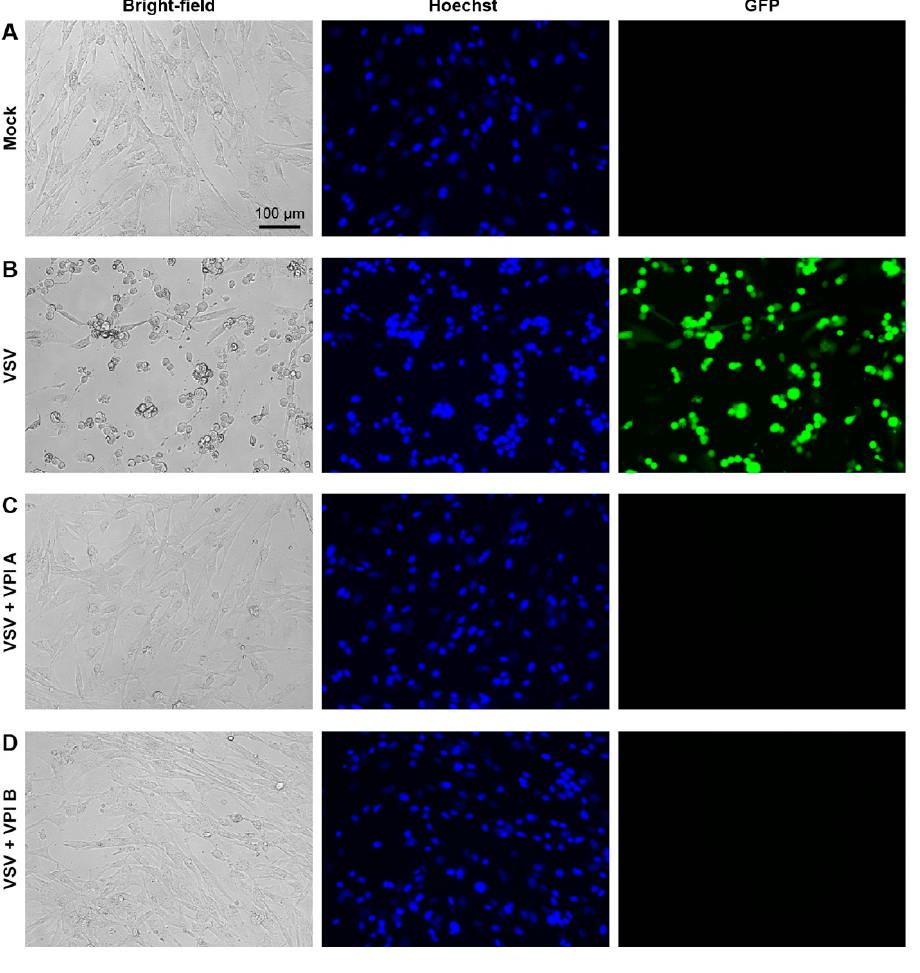
Figure 3. VPIs A and B inhibit VSV-induced CPEs and gene expression. BHK-21 cells were mock-infected ( A ) or infected with recombinant VSV expressing AcGFP at an MOI of 0.1 ( B – D ) in the presence or absence ( A , B ) of 10 µM VPI A ( C ) or B ( D ). At 24 h post-infection, cells were stained with